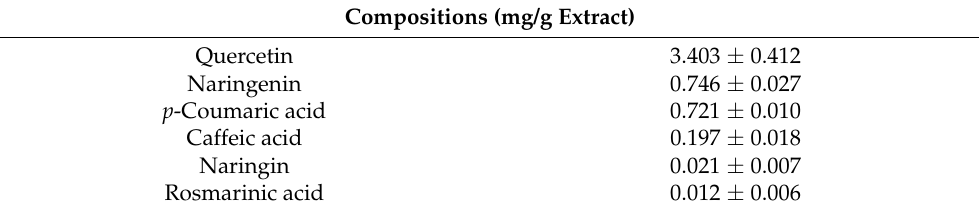
Table 1. Polyphenol compositions of Asparagus racemosus root